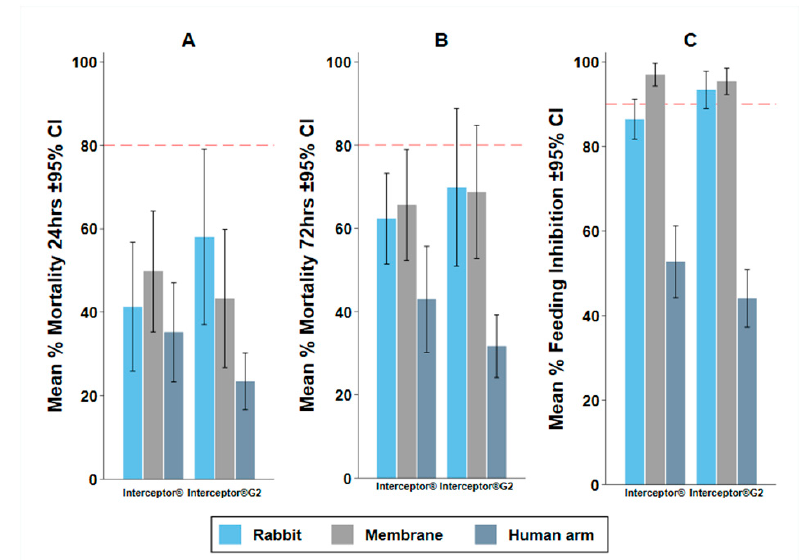
Figure 4. Mean percentage mortality and 95% Confidence Interval (CI) for mortality at ( A ) 24-h (M24), ( B ) 72-h (M72) post exposure and ( C ) blood feeding inhibition (BFI) for Interceptor ® and Interceptor ® G2 nets with 100 pyrethroid-resistant Anopheles arabiensis mosquitoes using rabbit, Hemotek ® membrane feeders and human arm as bait in the WHO tunnel bioassay. Red dashed line depicts the WHO minimum bioefficacy criteria of ≥ 80% M24 and ≥ 95% BFI.